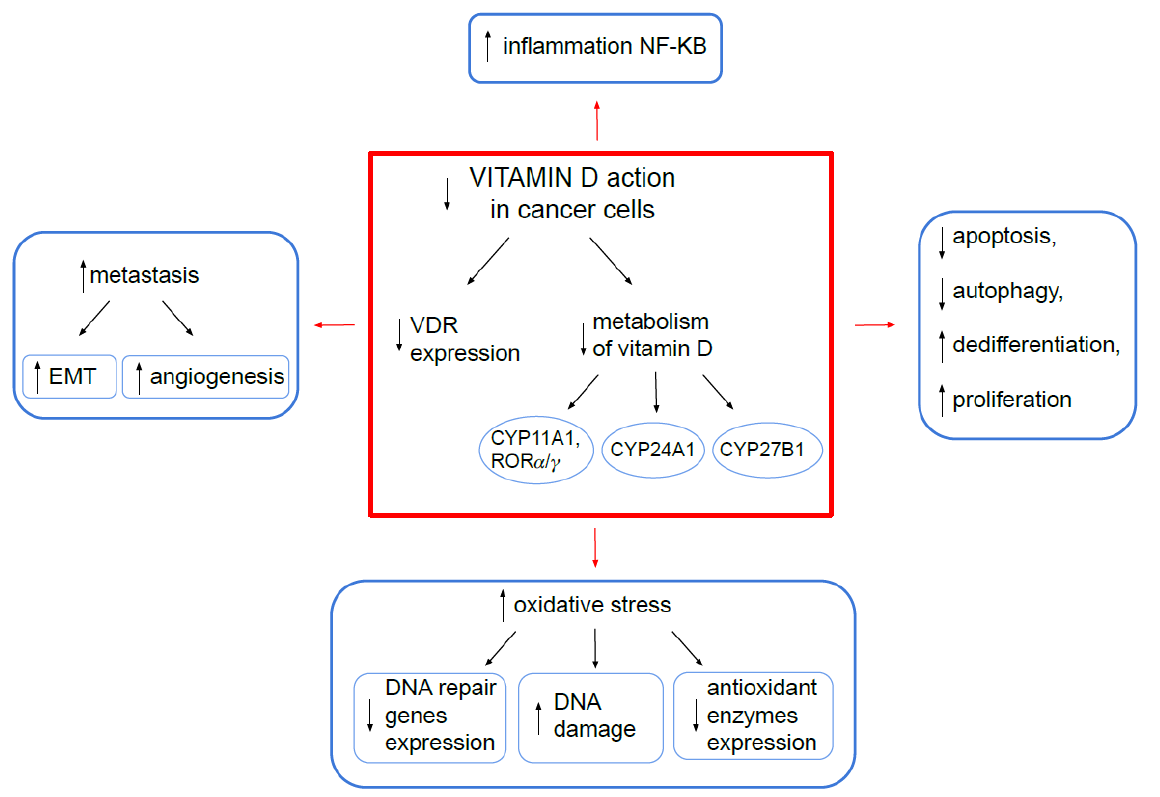
Figure 3. The potential mechanisms that link vitamin D deficiency and increased risk of cancer in T2DM.